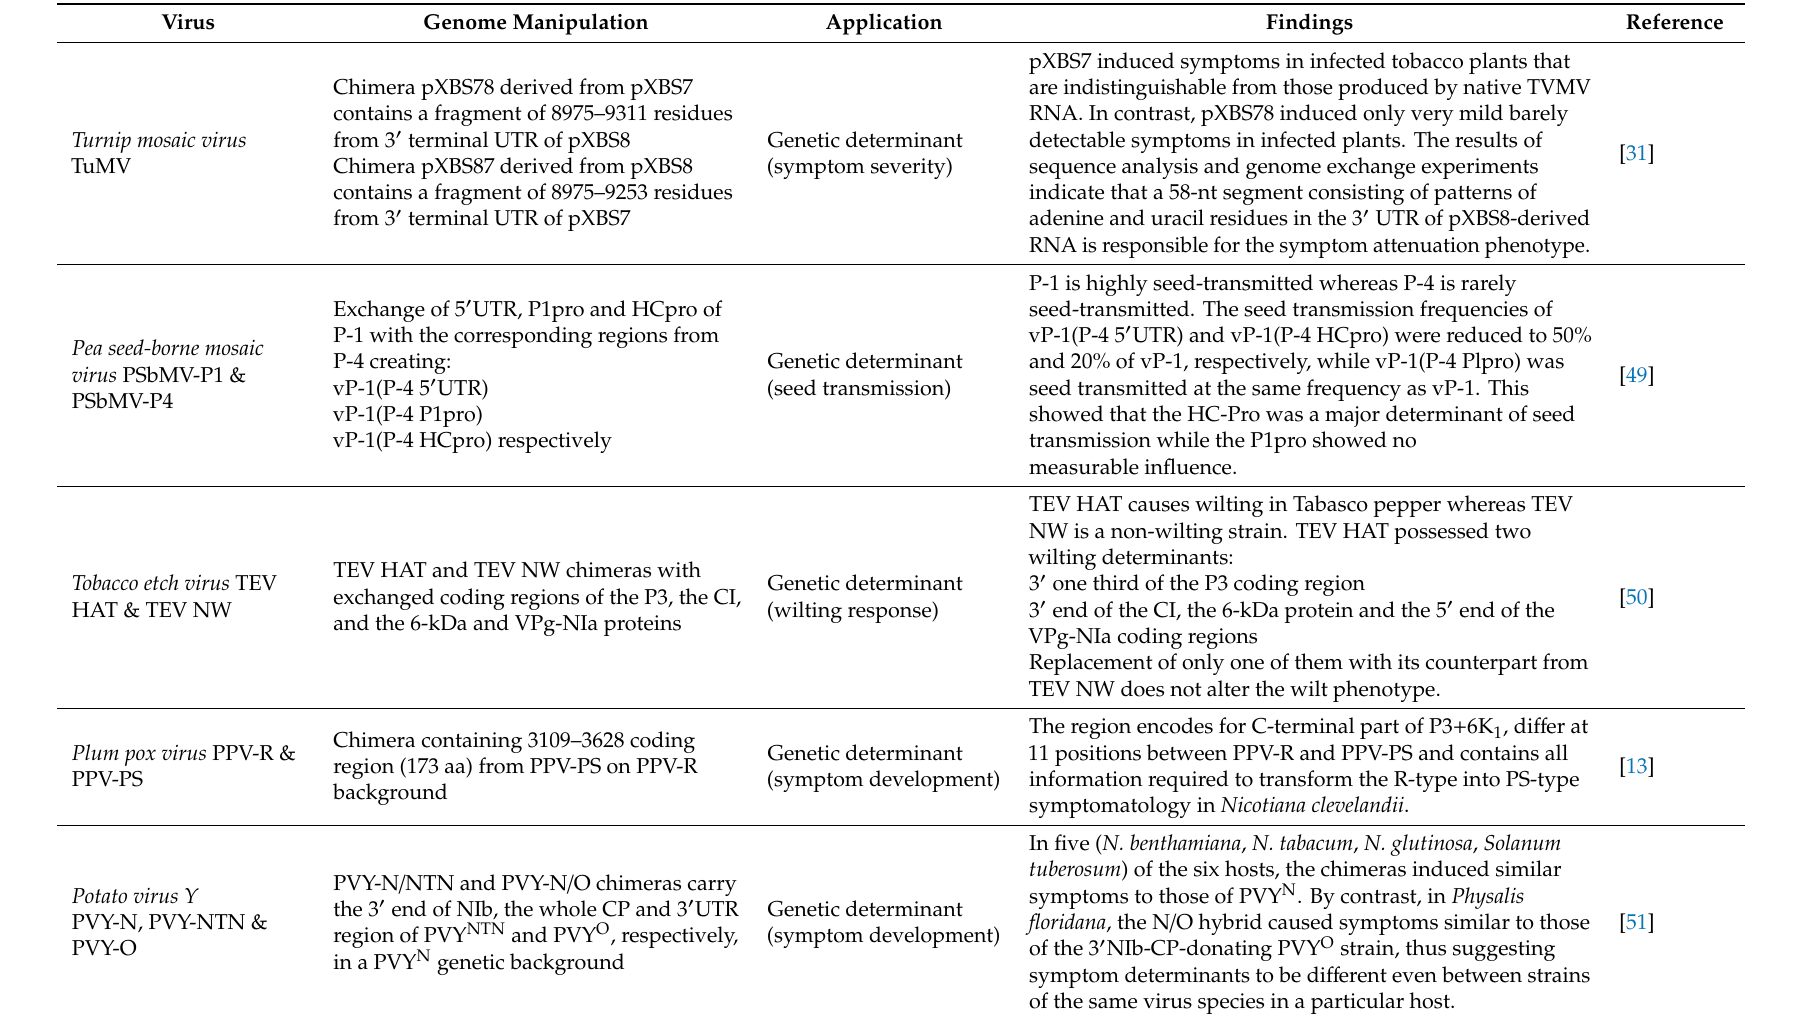
Table 2. List of molecular determinants mapped in potyviral genomes through reverse genetics